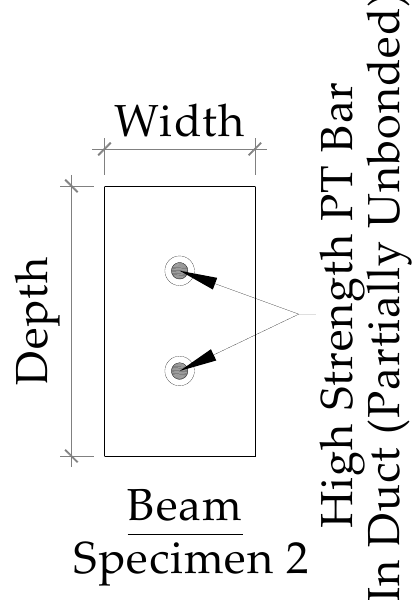
Figure 15. PT bar (partially unbonded).